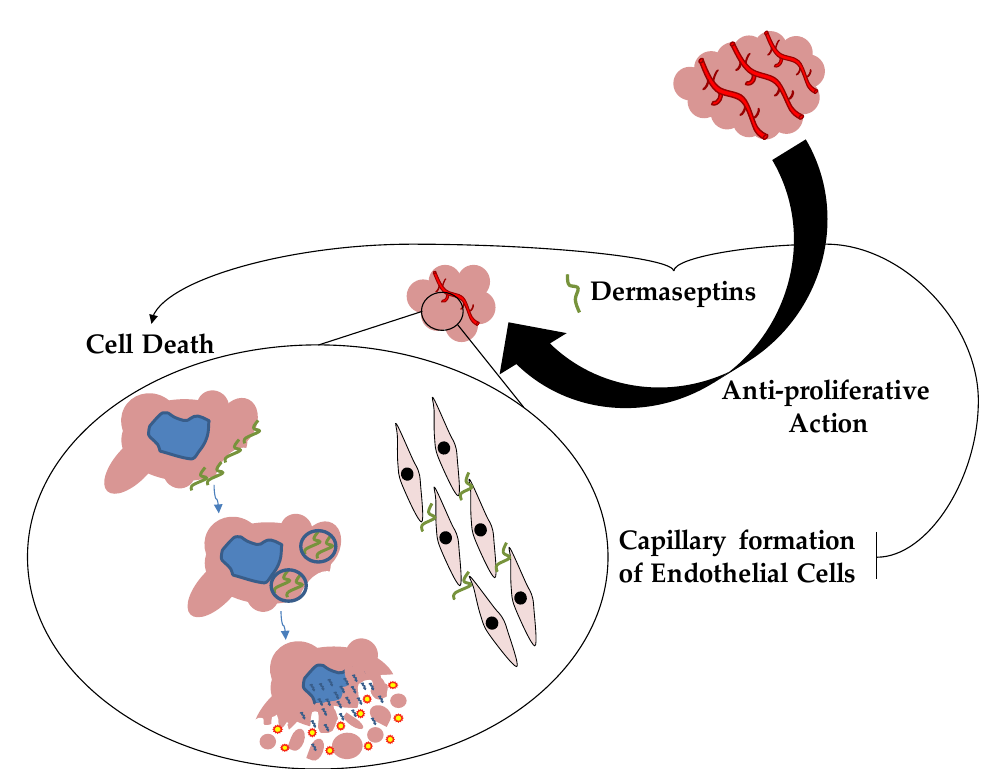
Figure 3. Dermaseptins and Cancer . Dermaseptins act as an anti-proliferative agent against several cancer cells in vitro and in vivo. The anticancer mechanism of action is based on the ability of these MF-AMPs to accumulate in cancer cells, inducing cell death and blocking tumor vascularization.